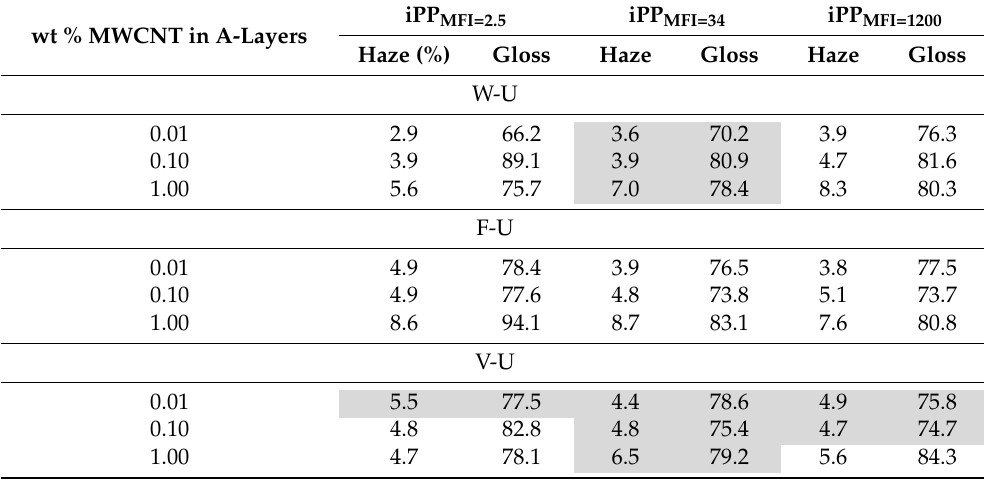
Table 5. Haze and brightness for ABA films fabricated using masterbatches with MFI = 2.5, 34 and 1200 g/10 min. The masterbatches were fabricated using ultrasound-assist methods: W-U, F-U and V-U. iPP wt % MWCNT in A-Layers